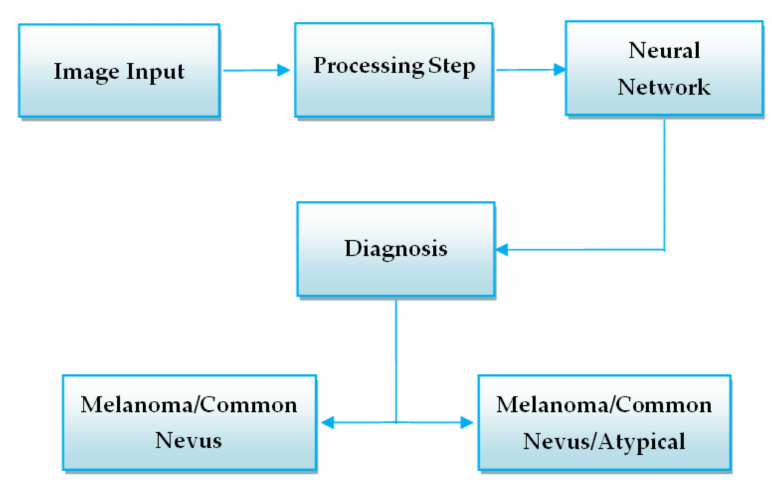
Figure 5. Proposed method – Neural Network used as